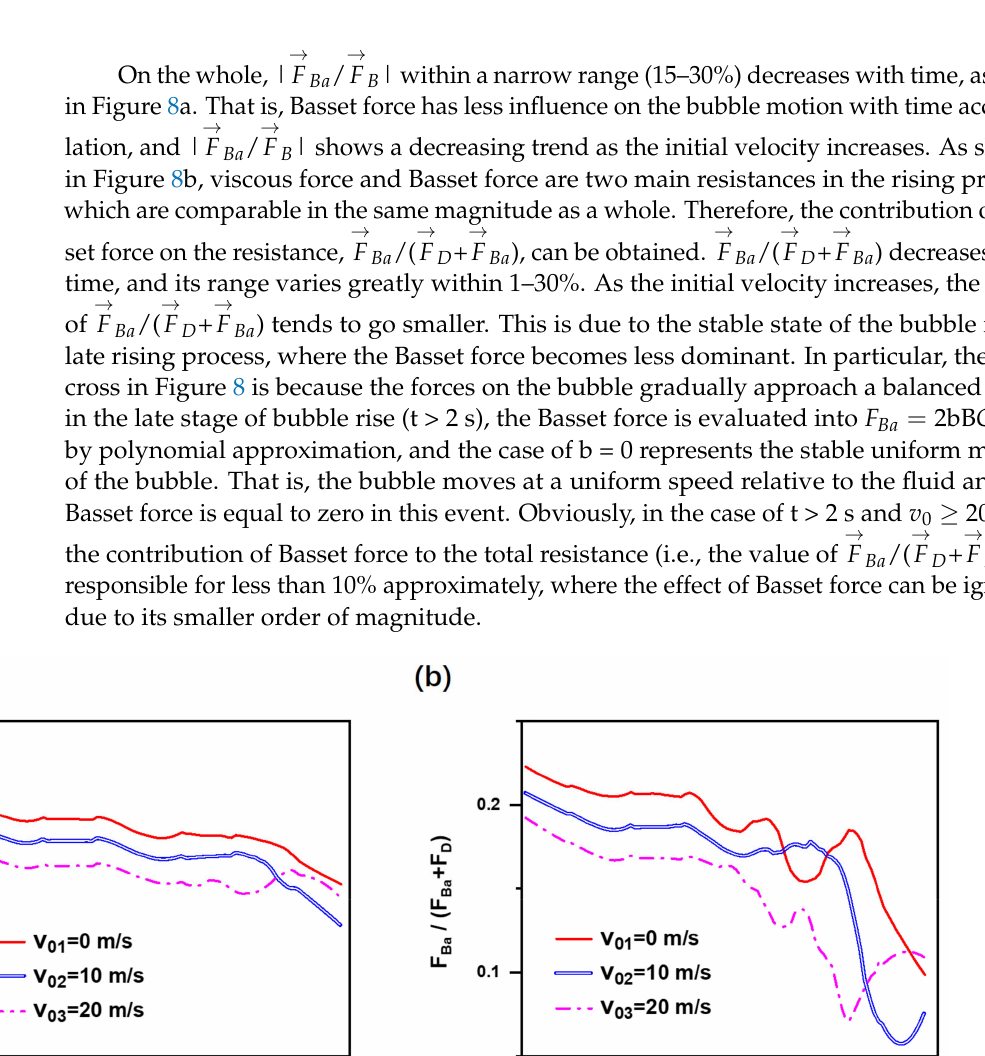
Figure 8. ( a ) | ρ f = 1000 kg/m 3 , ρ b = 1.29 kg/m 3 in quiescent